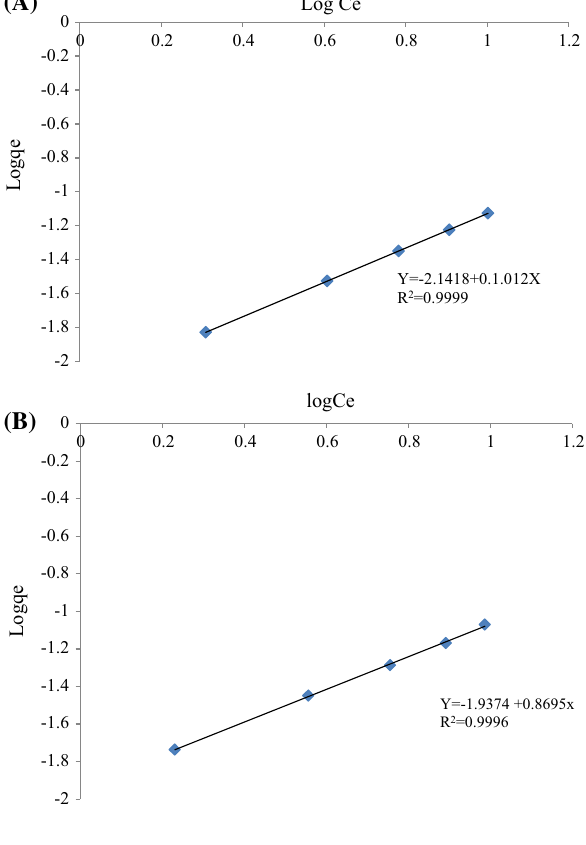
Fig. 5 Freundlich isotherm for the removal of fluoride using a acti- vated mica (MAA) and b mica impregnated with iron (MI)